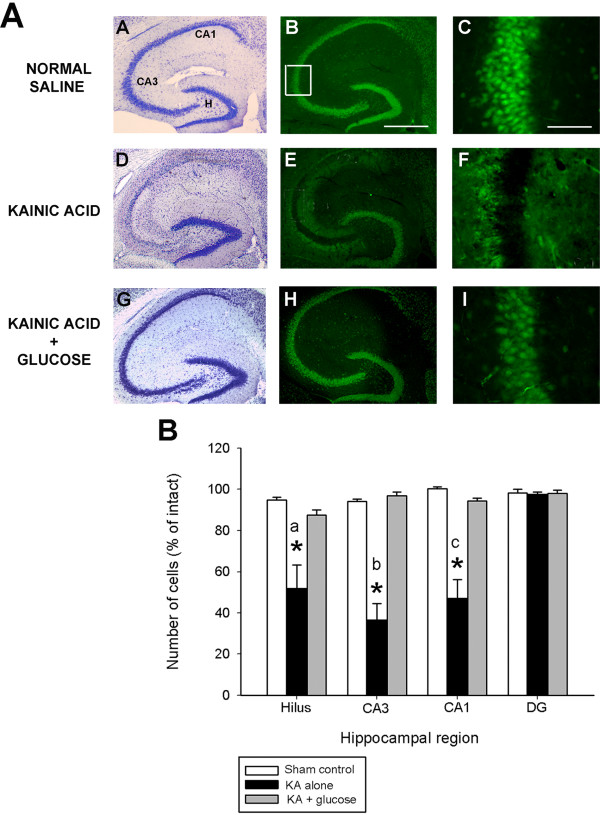
Glucose infusion suppresses neuronal damage following kainate-induced status epilepticus. (A) Low-magnification photomicrographs of cresyl violet (A,D,G) and NeuN-immunofluorescent (B,E,F) stained horizontal sections of the hippocampus illustrating surviving cells throughout the hippocampus 7 days following systemic kainate administration to FVB mice. High-magnification NeuN-immunofluorescent stained horizontal sections of area CA3 (C,F,I) among the three groups. Neuron loss following status epilepticus was profoundly reduced when exogenous glucose was administered for 3 consecutive days following seizure induction. Note the significant amount of cell loss in representative sections from KA-treated mice in the dentate hilus, area CA3 and area CA1, depicted as an absence of cresyl violet stain (D) or NeuN-immunofluorescence (E). Cell loss was not observed after post-seizure glucose infusion (G,H,I). CA1 and CA3 denote the hippocampal subfields; H, dentate hilus. Scale bar = 750 μm (A,C); 100 μm (B,D). High-magnification photomicrographs represent details of the boxed area of CA3 shown in B. (B) Quantitative analysis of neuronal density in hippocampal subfields seven days following KA administration to FVB mice. Viable surviving neurons were estimated by cresyl violet staining. Bars denote the percentage of surviving neurons (as compared with saline-injected sham control FVB mice). Data represent the mean ± S.E.M. of at least 5 mice per condition. Asterisks indicate significant difference compared with KA alone or Sham control of P<0.05. (ANOVA with post hoc Student Newman Keuls; a: F=9.68, P=0.003; b: F=42.87, P<0.001; c: F=23.76, P<0.001).